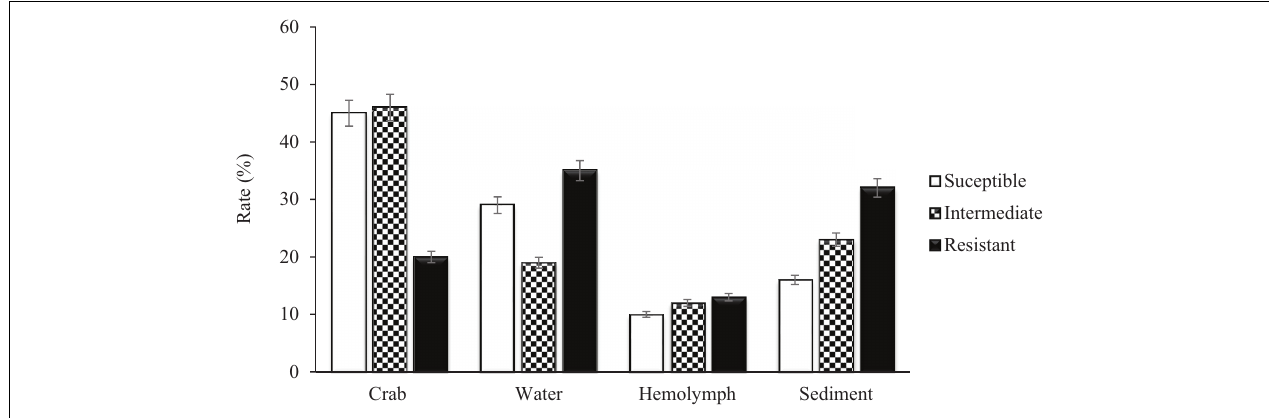
FIGURE 2 | Percentage of Vibrio vulnificus isolates susceptible, intermediate and resistant to Cephalothin.